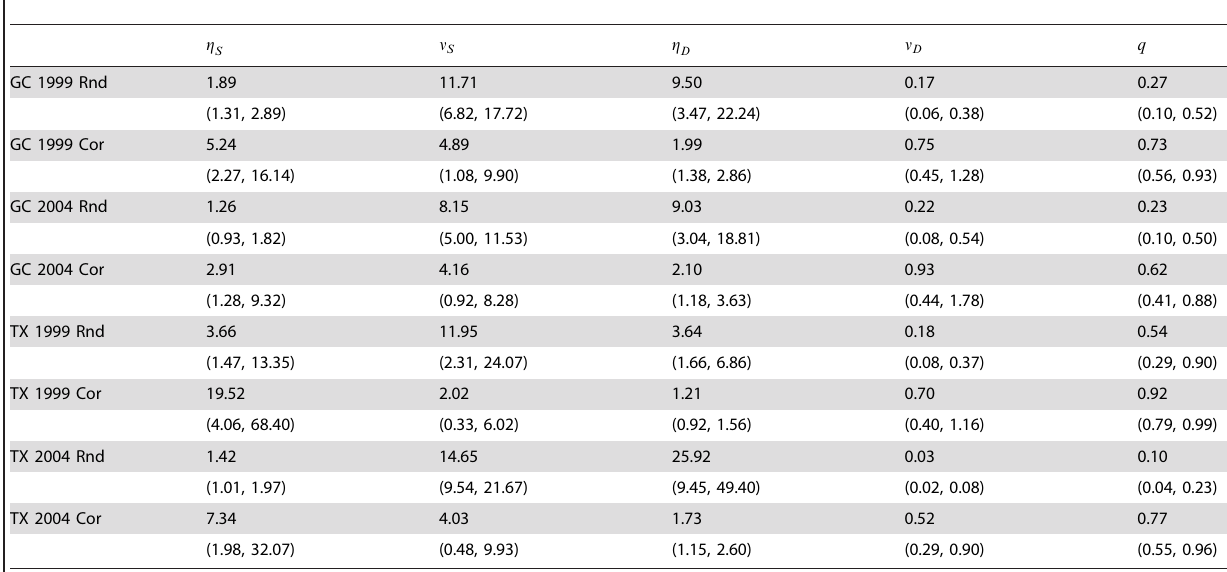
Table 2. Grid-specific Bayesian mean estimates for the accumulation model